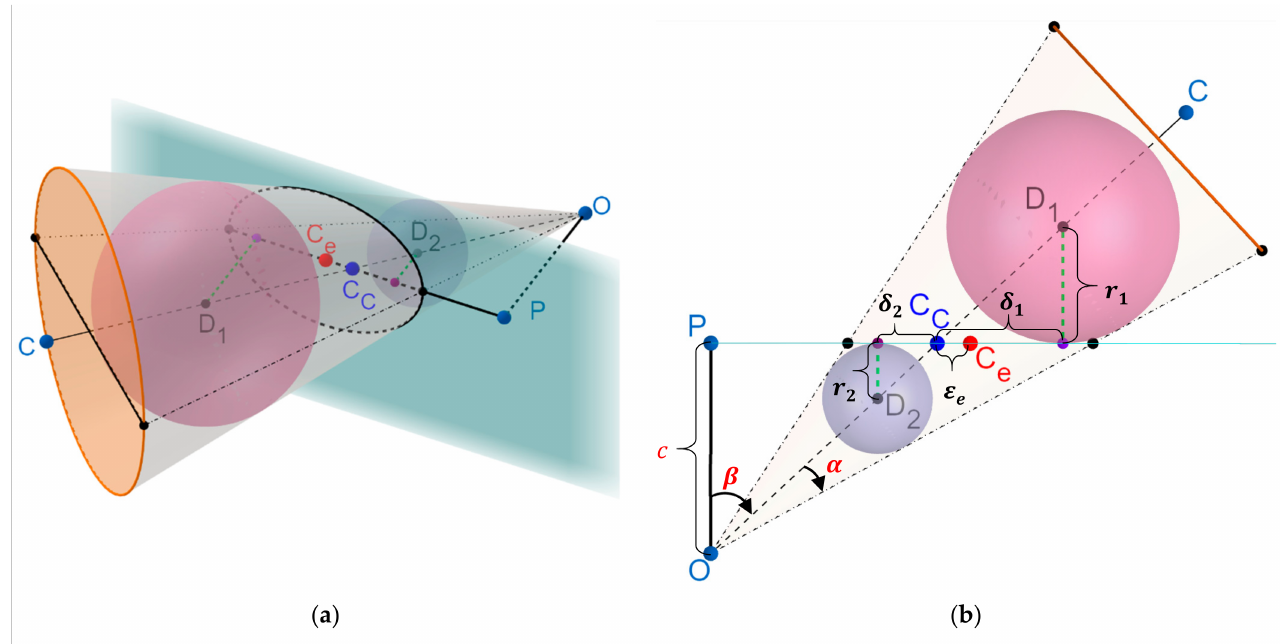
Figure 1. Geometry of the intersection of a plane and a cone: ( a ) 3D orthographic view; ( b ) projected onto the plane whose normal vector is parallel to the minor axis of the intersecting ellipse. The images were generated using GeoGebra, a dynamic geometry, mathematics, and algebra software